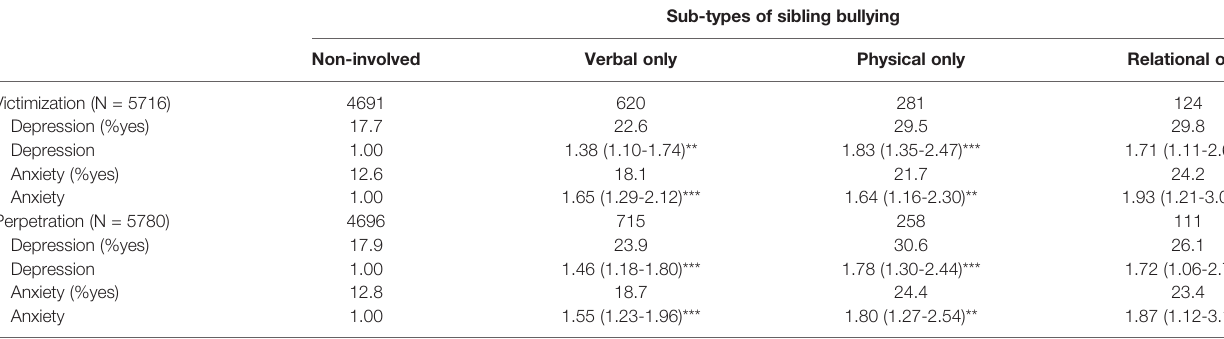
TABLE 3 | The associations between different sub-types of sibling bullying involvement and depression and anxiety [Adjusted OR (95%